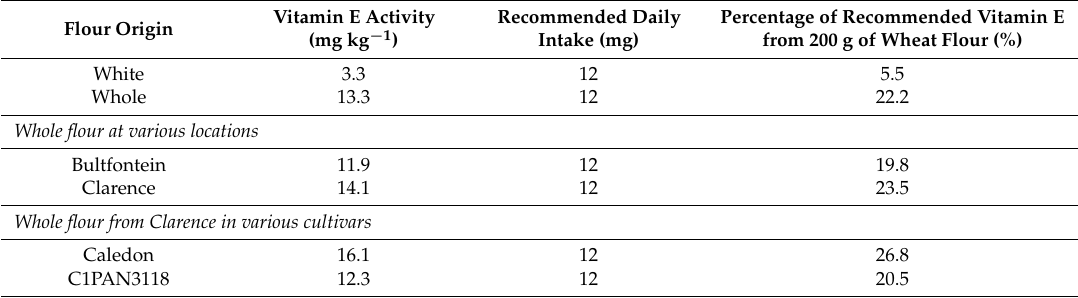
Table 5. Vitamin E activity of wheat flour of different fractions, genotypes, and localities, calculated as tocopherol equivalents [7] and percentage of recommended intake [11,19] from the average flour consumption in the world of 200